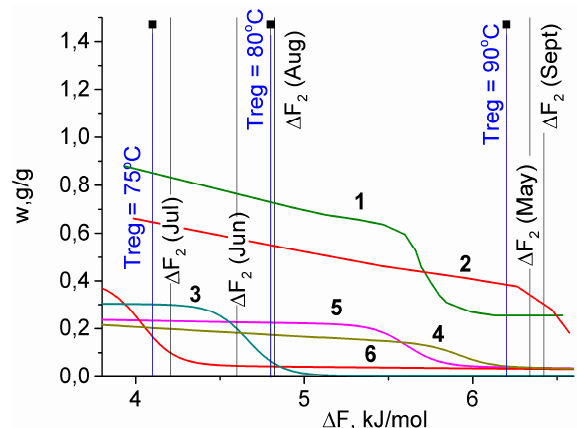
Figure 5. Boundary conditions for the adsorptive heating cycles ( T con = T ads = T uh = 45 ◦ C) considered and the universal curves of water adsorption on the adsorbents, promising for Oimyakon (Table 2). Vertical lines—boundary potentials of the cycle (black—sorption stage, blue—desorption stage). 1—LiCl/vermiculite, 2—LiCl/ MWCNT, 3—CAU10, 4—Ca(NO 3 ) 2 /silica, 5—ALPO18, 6—MIL125NH2.